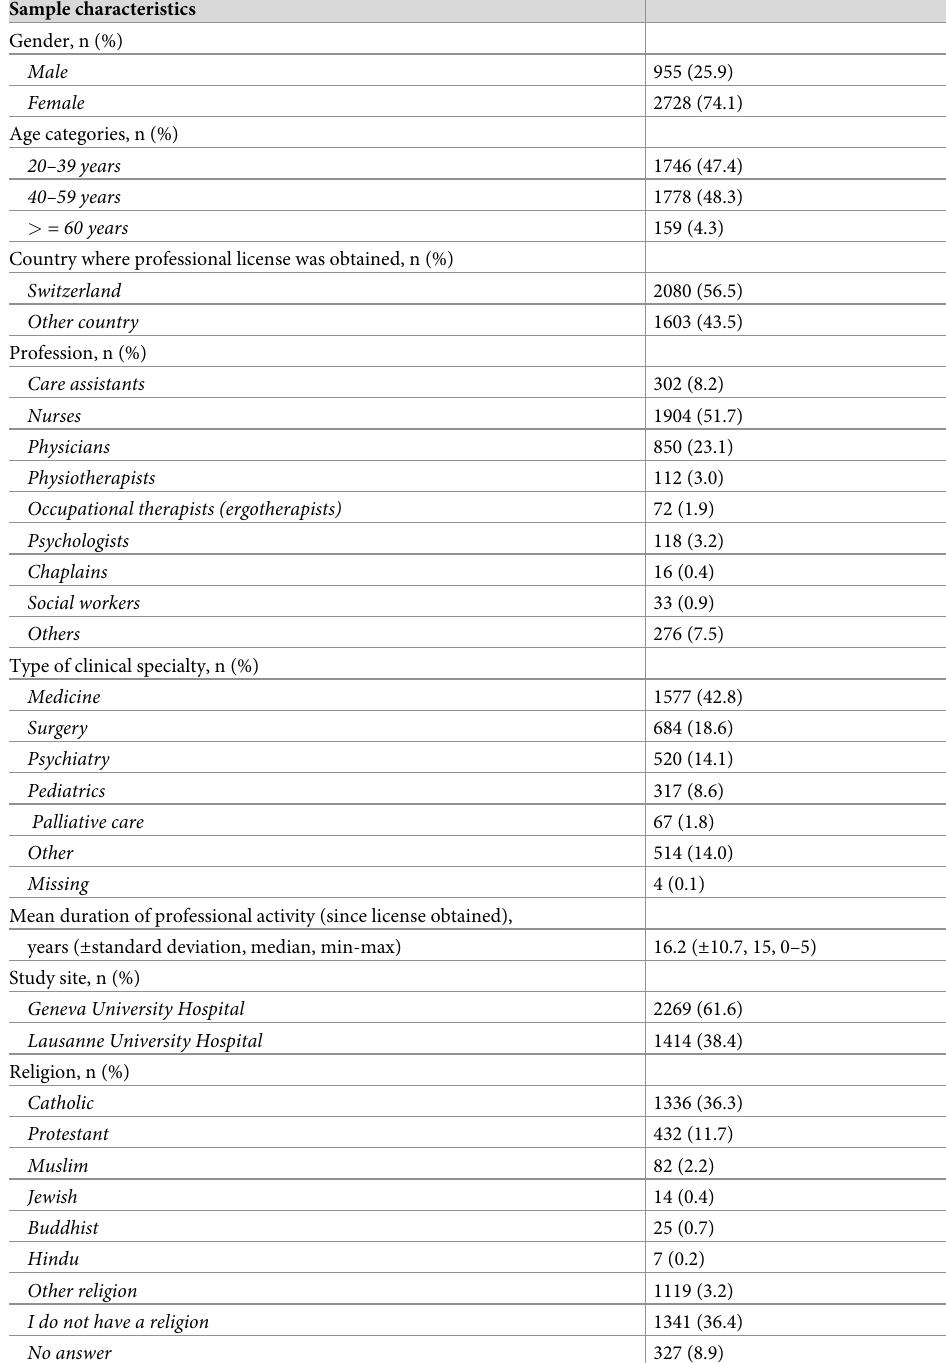
Table 1. Principal characteristics of the sample (N =